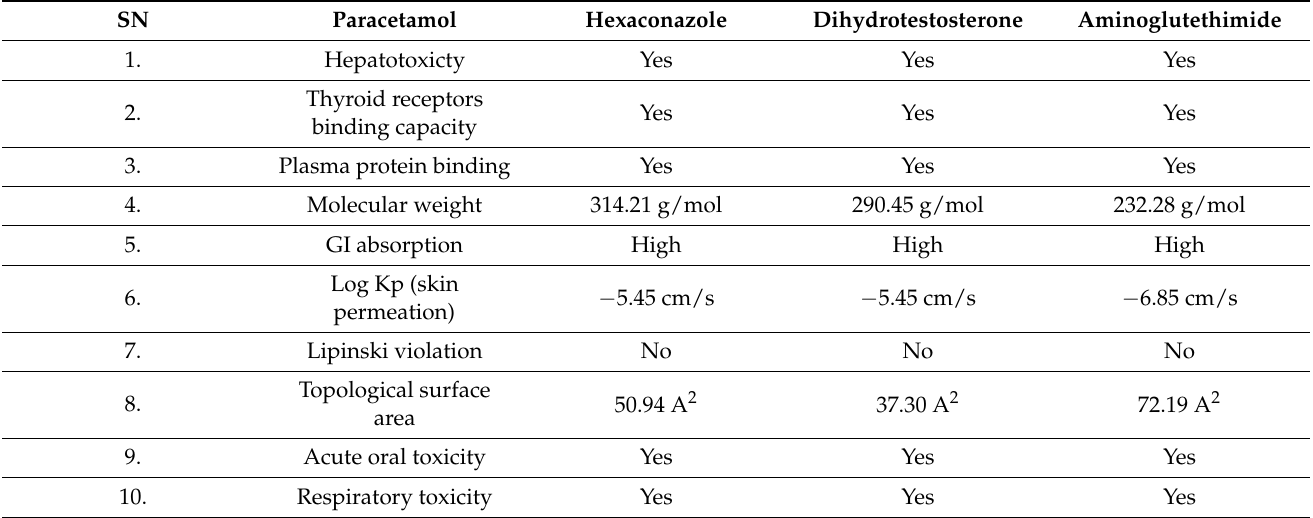
Table 3. ADME and toxicity